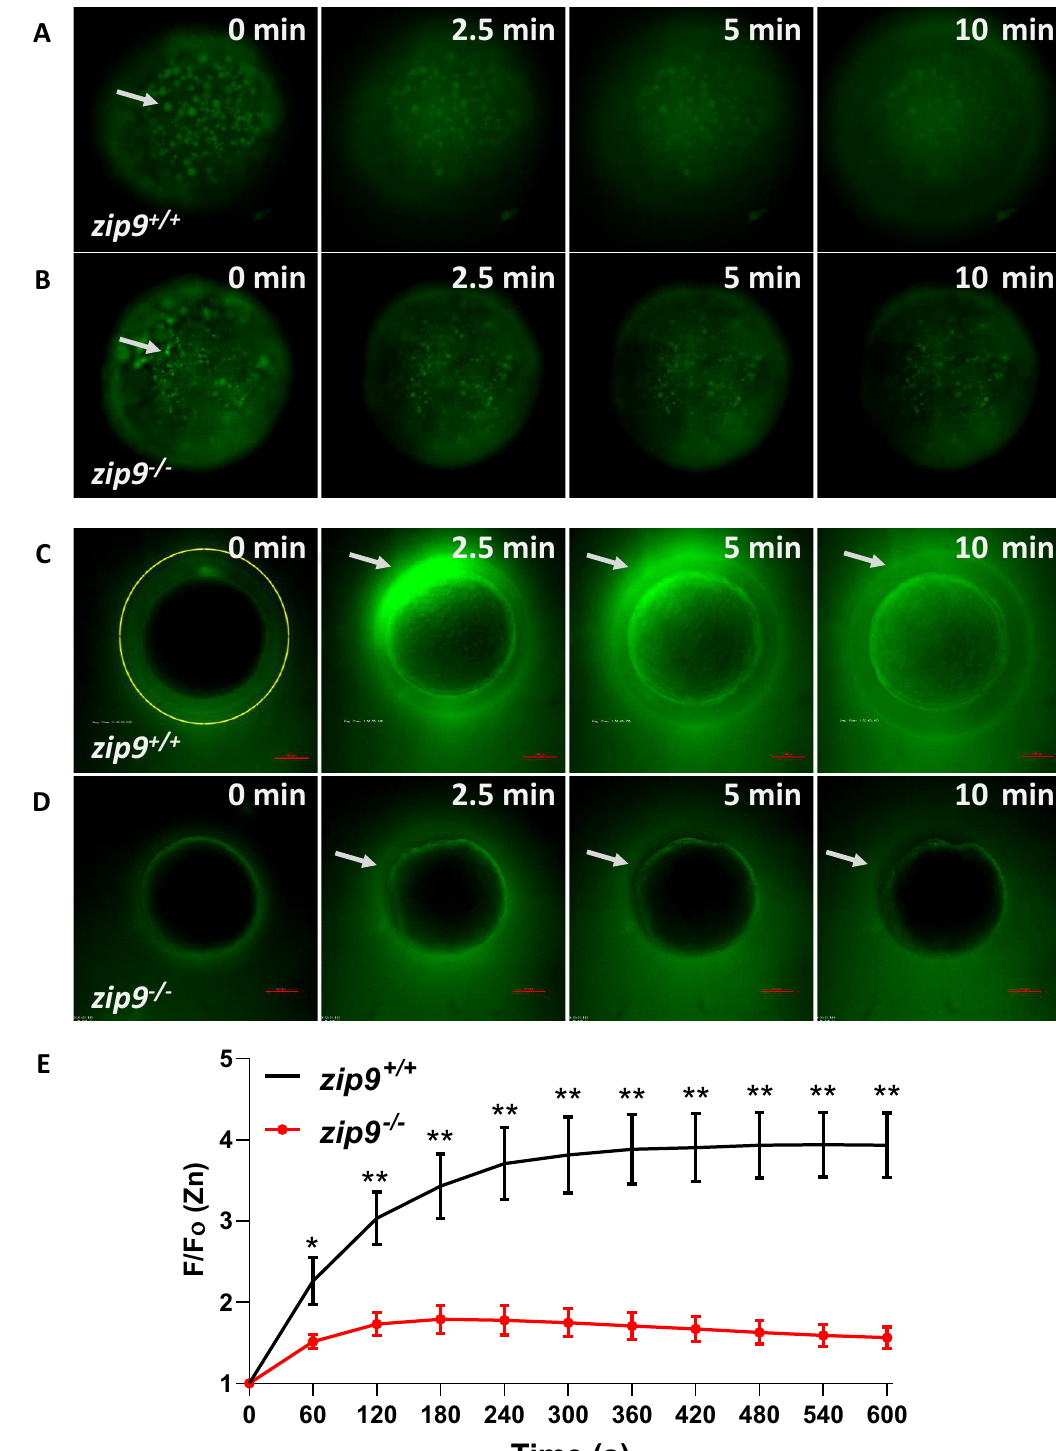
Figure 5. Zinc is stored in cortically-localized vesicles that undergo exocytosis upon egg activation. (A, B) zip9 + / + (A) and zip9 -/- (B) eggs show intracellular zinc staining (arrows, 0 min) in cortically-localized vesicles that are reduced in number at 2.5–10 min post-activation. (C, D) Extracellular zinc is observed 2.5–10 min post-activation of zip9 + / + (C) and zip9 -/- (D) eggs. (E) Time trace of normalized extracellular zinc fluorescence by ROI analysis (ROI denoted by yellow circle in C , 0 min) 0–10 min post-activation of zip9 + / + and zip9 -/- eggs. Visualization was performed on eggs from a minimum of 3 females/strain. For (E) , data represents means ± SEM; n = 5–6. Significance was determined by Welch’s t -test (*, P < 0.05; **, P <